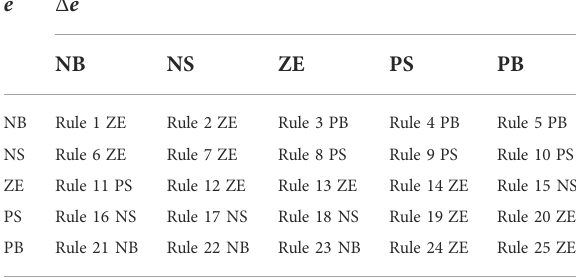
TABLE 4 Rule base table for fuzzy MPPT